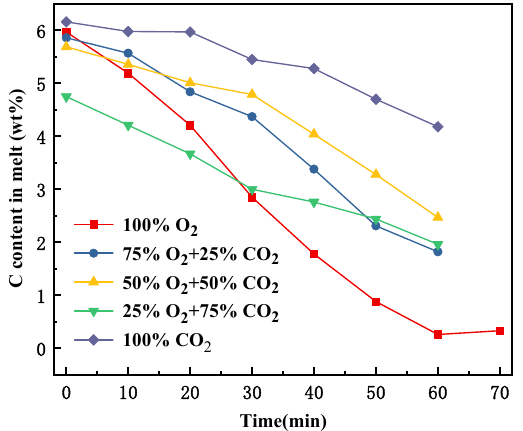
Figure 3. Variation in carbon content with time by blowing different CO 2 ‐ O 2 mixtures .